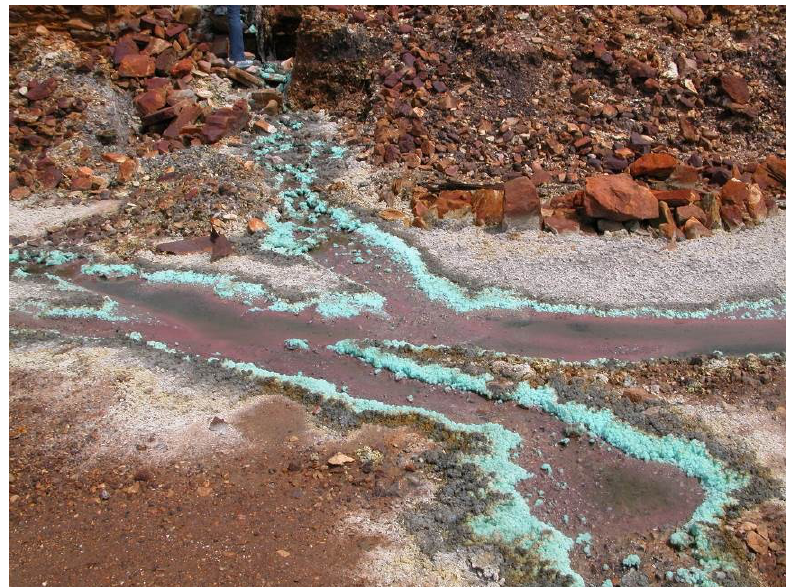
Figure 3. Evaporitic sulphate salts at the toe of a spoil heap in the Río Tinto mine. These salts were collected in the summer since the Middle Ages for the manufacture of dyes and other uses.